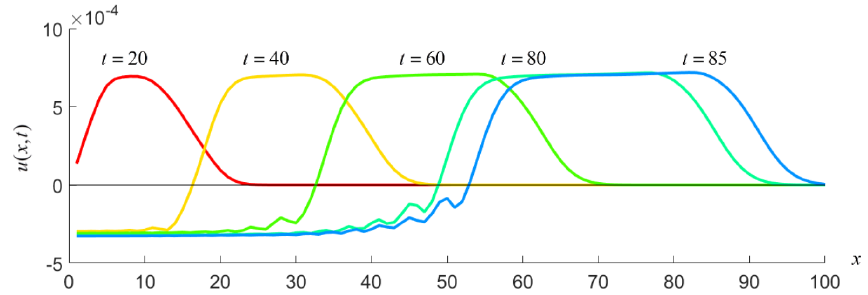
Figure 2. Displacement u(x,t) at different time moments versus the horizontal coordinate x for the compression–tension harmonic impulse.